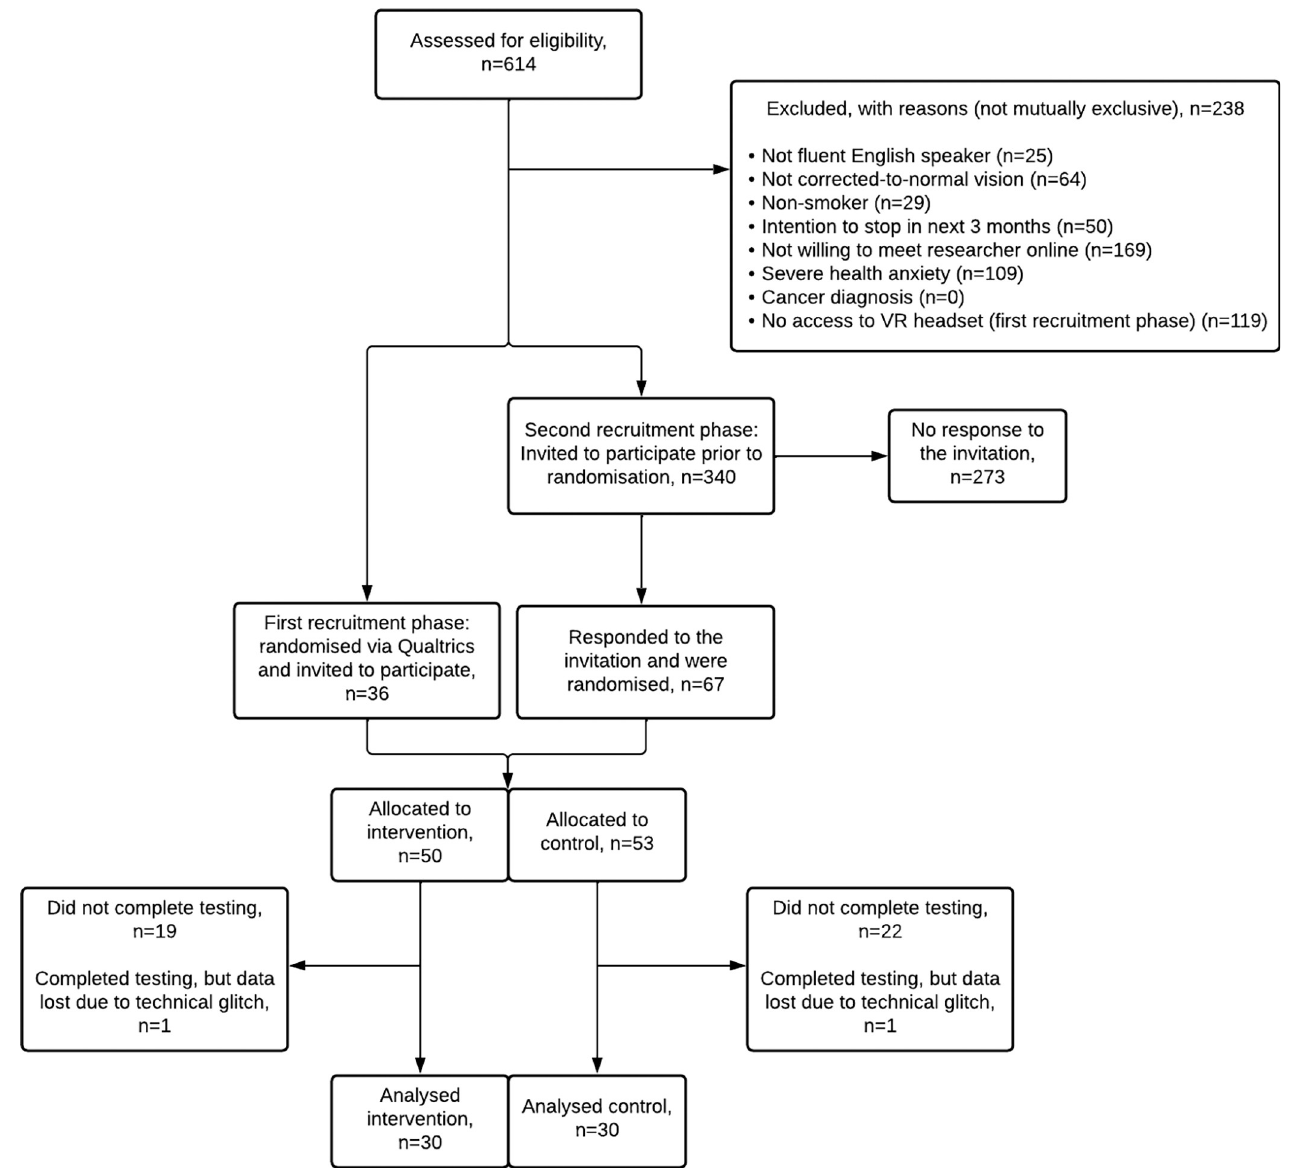
Fig 3. CONSORT flow diagram of the study